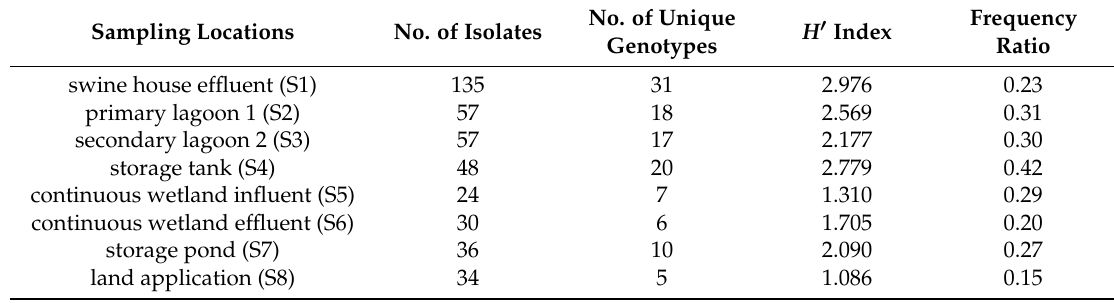
Table 3. Shannon diversity indices ( H ′ ) of E. coli isolates based on BOX PCR from different locations within the wetland.